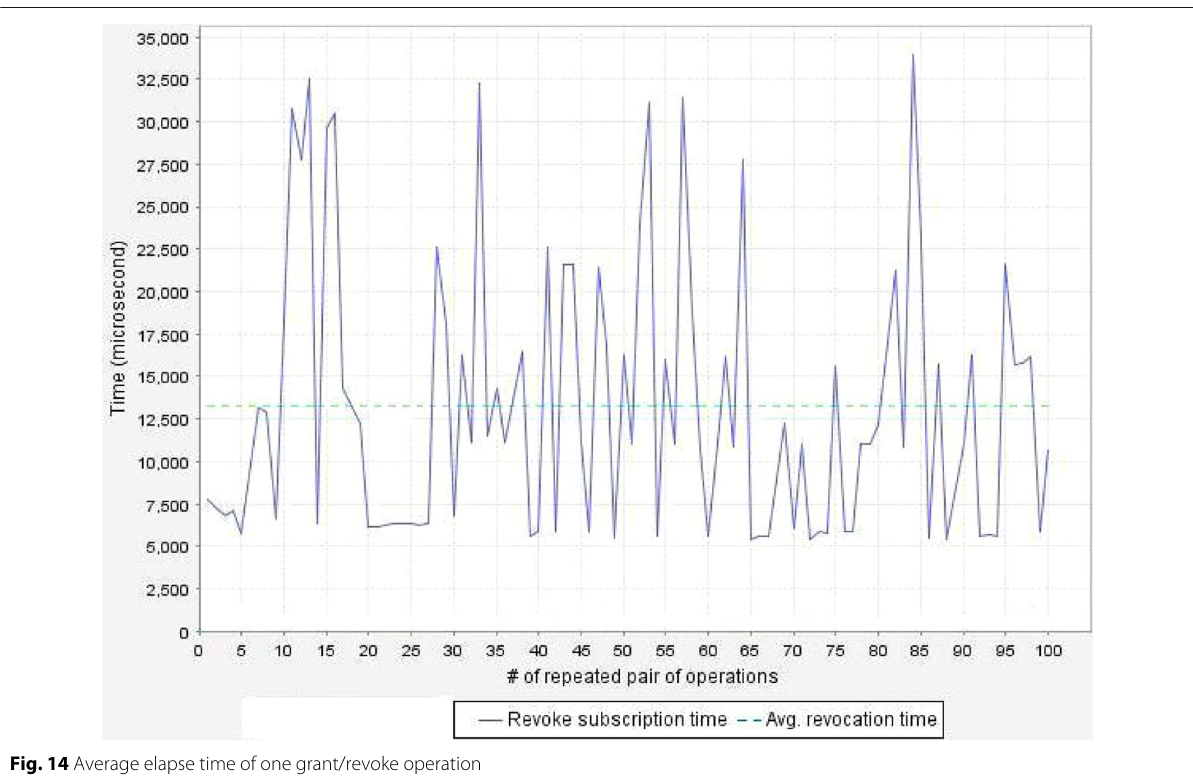
Fig. 14 Average elapse time of one grant/revoke operation